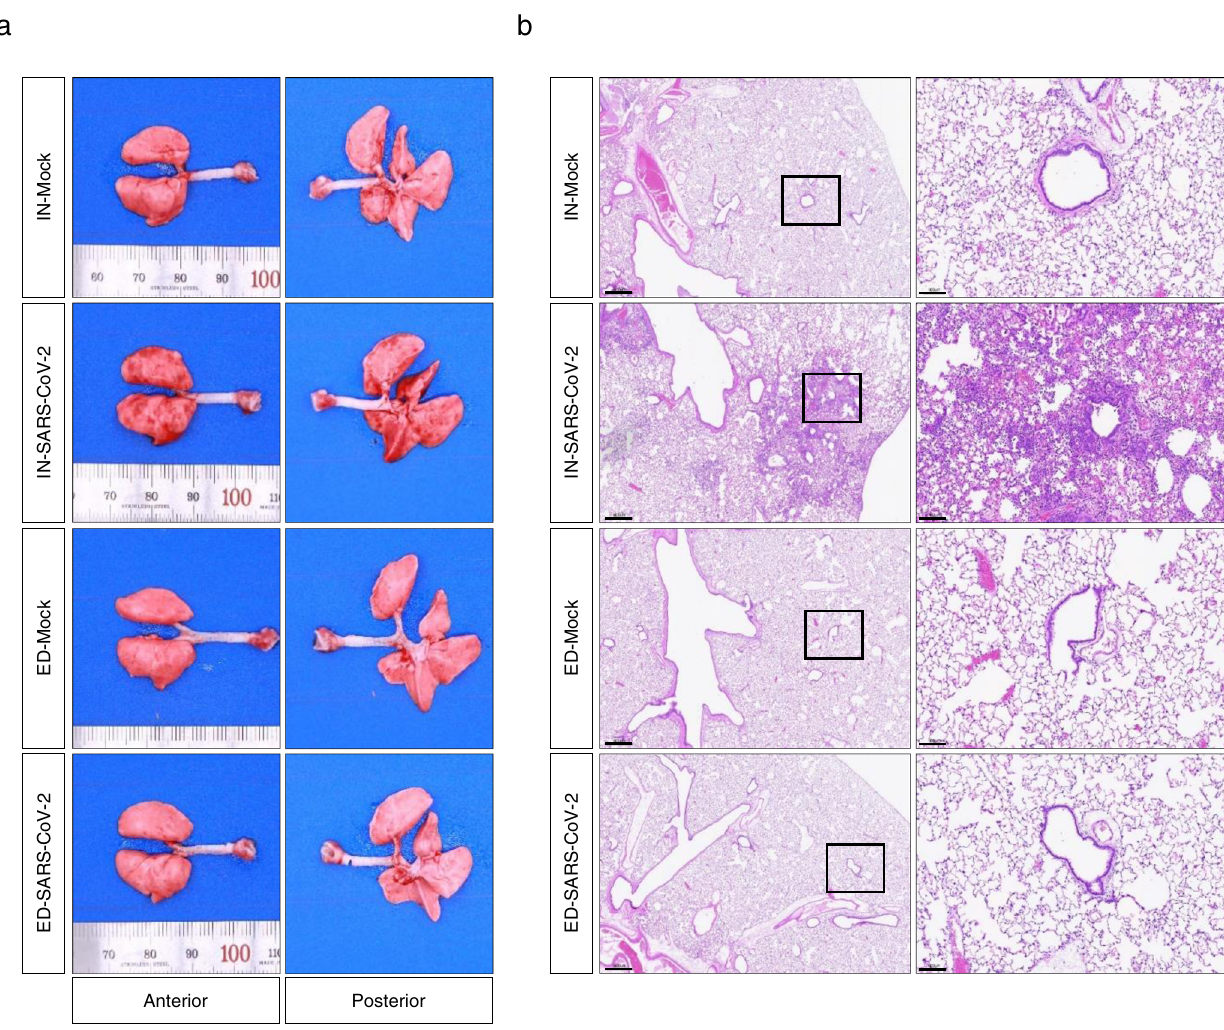
Fig. 7 | Gross and pulmonary histopathology of intranasally (IN) or eye-drop (ED)-infectedwild-typeSyrianhamsters. SyrianhamsterswereIN-orED-infected with10 4 PFUofSARS-CoV-2(each n =5forIN-mock-infected,IN-infected,ED-mock- infected, and ED-infected) a Representative digital image of lungs harvested from mock-infected or infected hamsters at 6 dpi. b Representative H&E stained lung